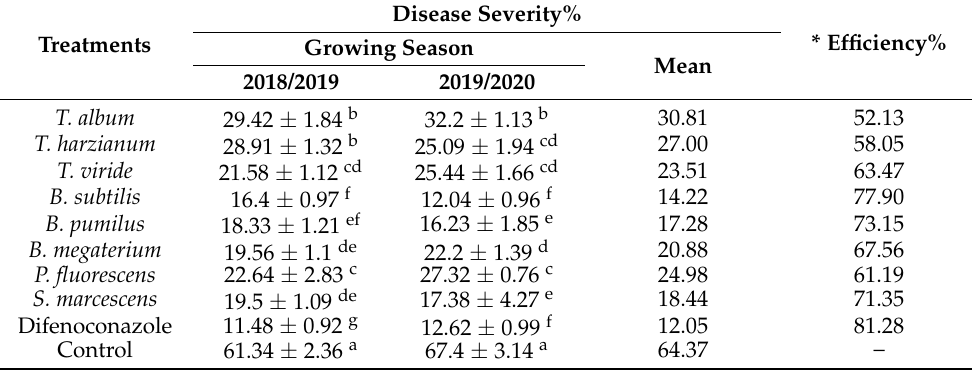
Table 3. Effect of tested biocontrol agents on the severity of celery powdery mildew during the